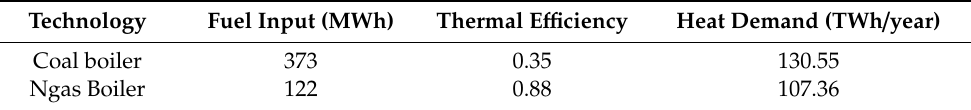
Table 1. Base Case (Coal and Ngas Boilers) Components